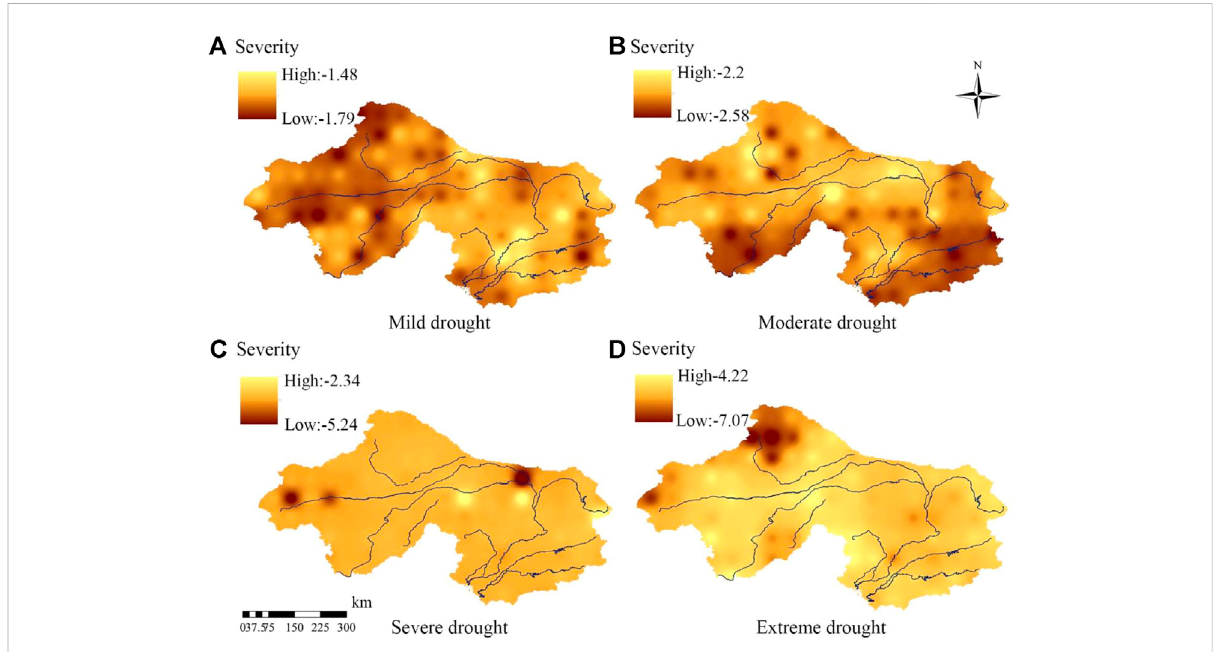
FIGURE 5 Spatial distribution of droughtseverity atdifferent levels in theLRB from 1962 to 2019. (A) is mild drought, (B) is moderate drought, (C) is severe drought, (D) is extreme drought.